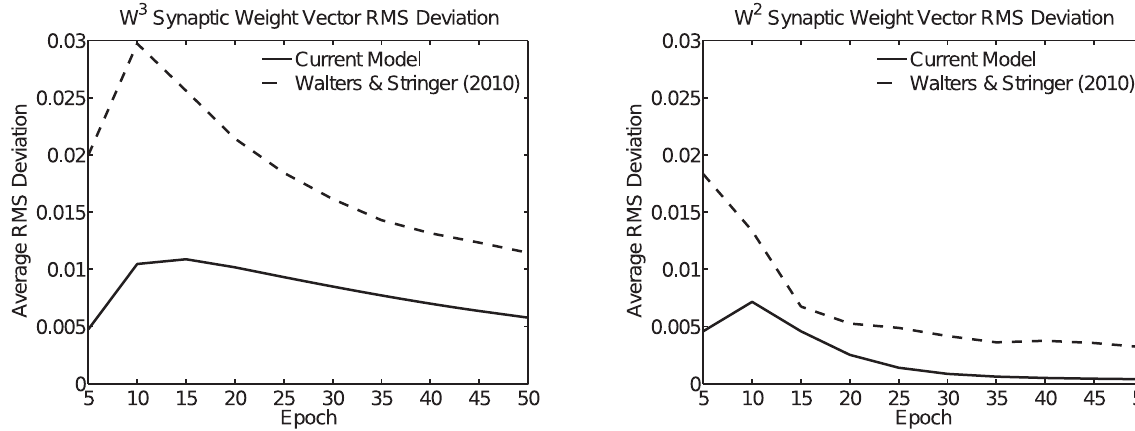
Figure 15. Convergence of the w 2 and w 3 synaptic weight vectors through time. Results are shown for the current model and for a previous model by the authors [22]. The plots display the root mean square (RMS) change in the synaptic weights across successive blocks of five training epochs for either the w 3 connections (left plot) or w 2 connections (right plot). For both models, the RMS change in the weights is monotonically decreasing after about 10–15 epochs. This implies that both the w 3 and w 2 synaptic weights are asymptotically converging to steady values. However, it is evident that convergence of the synaptic weights is much more rapid for the current model than the model of [22].